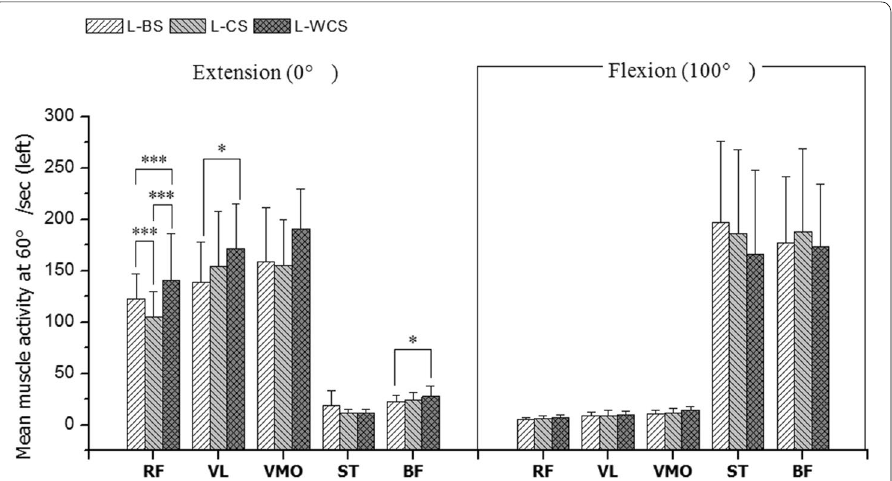
Fig. 3 Mean muscle activities of the left legs at the angular velocity of 60°/s: left (during knee extension); right (during knee